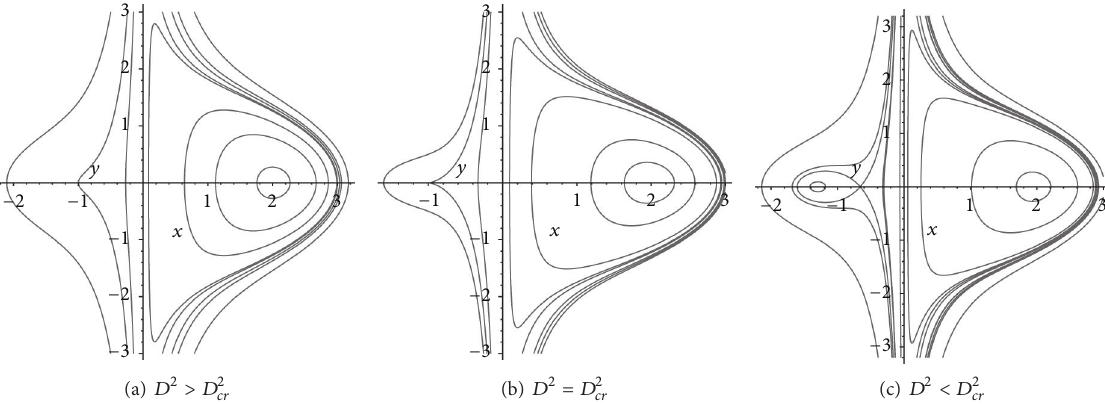
Figure 4: The phase portraits of system (6) for 𝑛 = 2𝑚 , 𝛽 < 0 , 𝐺 1 < 0 , and 𝜎 < 0